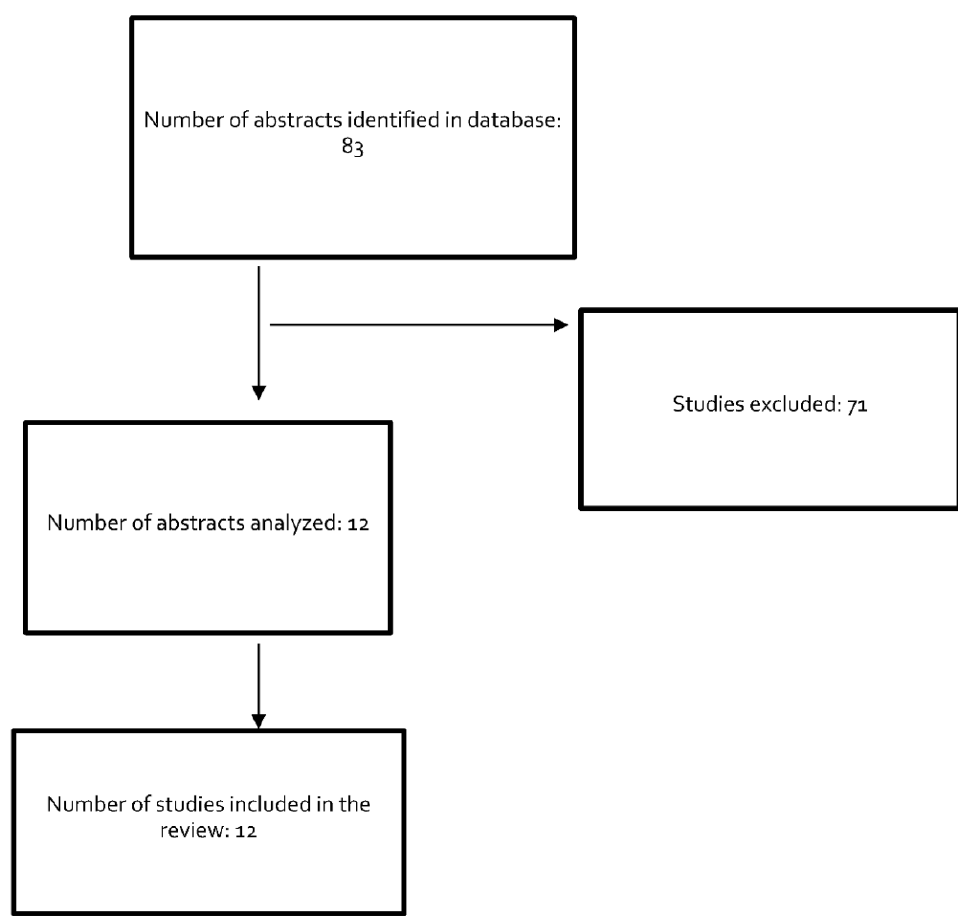
Figure 1. Flowchart of study selection for the narrative review.